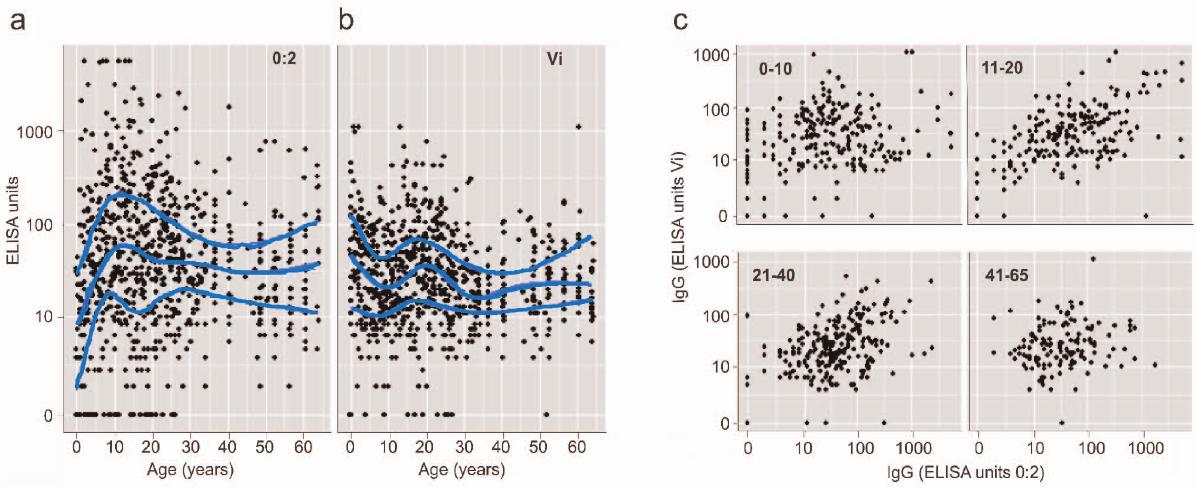
Figure 2. IgG serology against Vi-antigen ( S. Typhi) and 0:2-antigen ( S. Paratyphi A) in an age-stratified cross-section of the population of Kathmandu. a) Scatter plots showing antibody (IgG) levels against 0:2-antigen (left) and Vi-antigen in an age stratified population of Kathmandu, Nepal. Smoothed lines correspond to age-dependent median and quartiles which were estimated based on quantile regression with age included as a natural cubic spline function with 5 degrees of freedom. b) Age stratified scatter plots scatterplots (clockwise, 0–10 years, 11–20 years, 21–40 years and $ 40 years) of IgG 0:2 (x axis) and IgG Vi (y axis). doi:10.1371/journal.pntd.0002391.g002 PLOS Neglected Tropical Diseases |